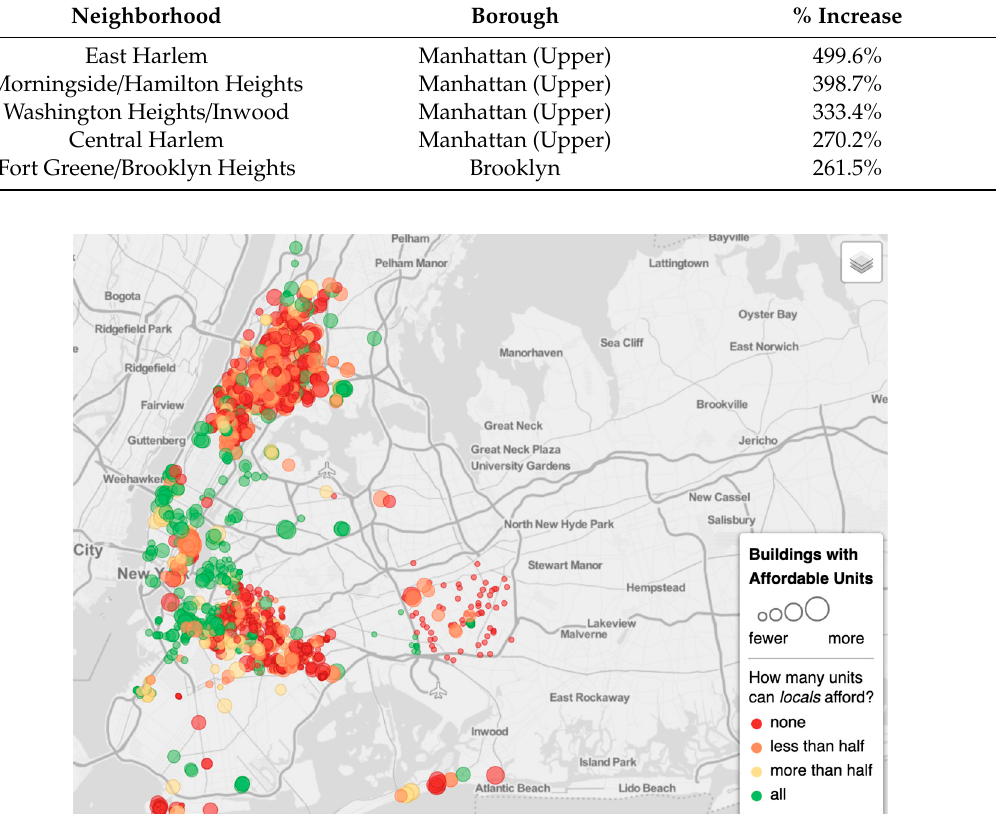
Int. J. Environ. Res. Public Health 2019 , 16 , x FOR PEER REVIEW Figure 3. Buildings with affordable units for a typical median household, New York City (2018). Figure 3. Buildings with a ff ordable units for a typical median household, New York City (2018).